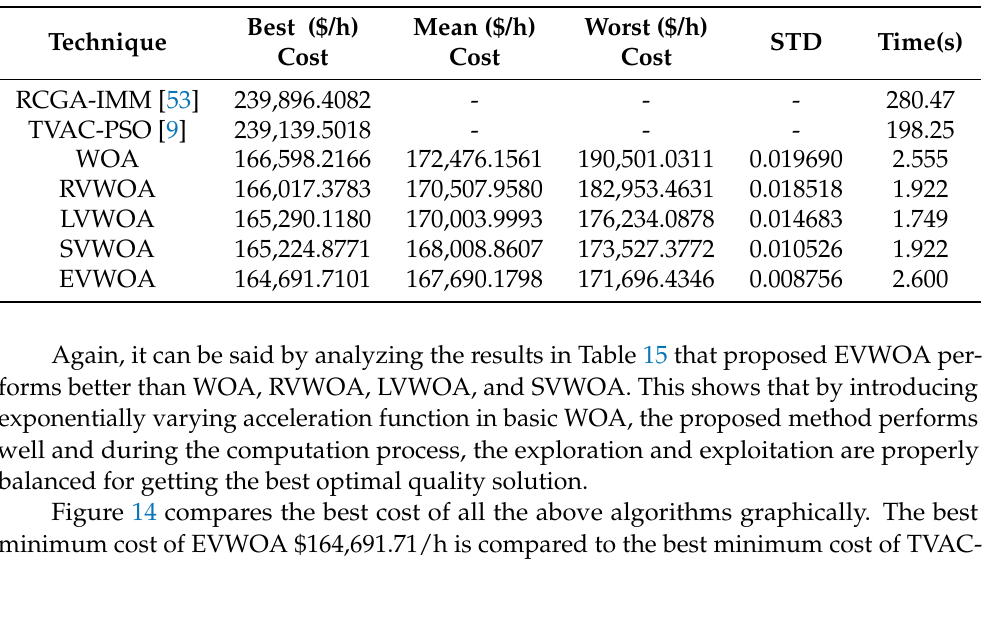
Figure 14 compares the best cost of all the above algorithms graphically. The best minimum cost of EVWOA $164,691.71/h is compared to the best minimum cost of